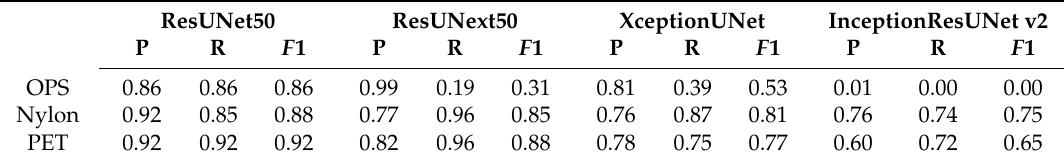
Table 3. Comparison of di ff erent encoder architectures for floating plastic detection (where P, R, F 1, are precision, recall, and F 1-score respectively) (Dataset